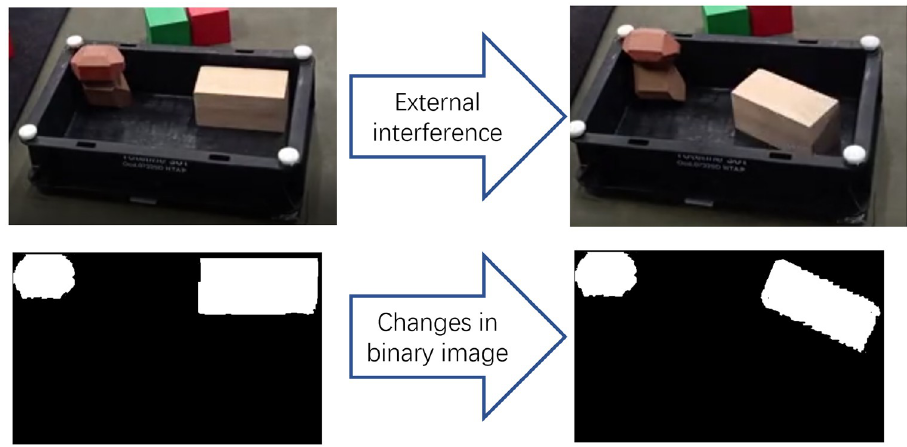
Fig 6. External interference detection. When the distribution of parts in the bin changes due to external interference, the algorithm can still work normally when observed by hand-eye camera.